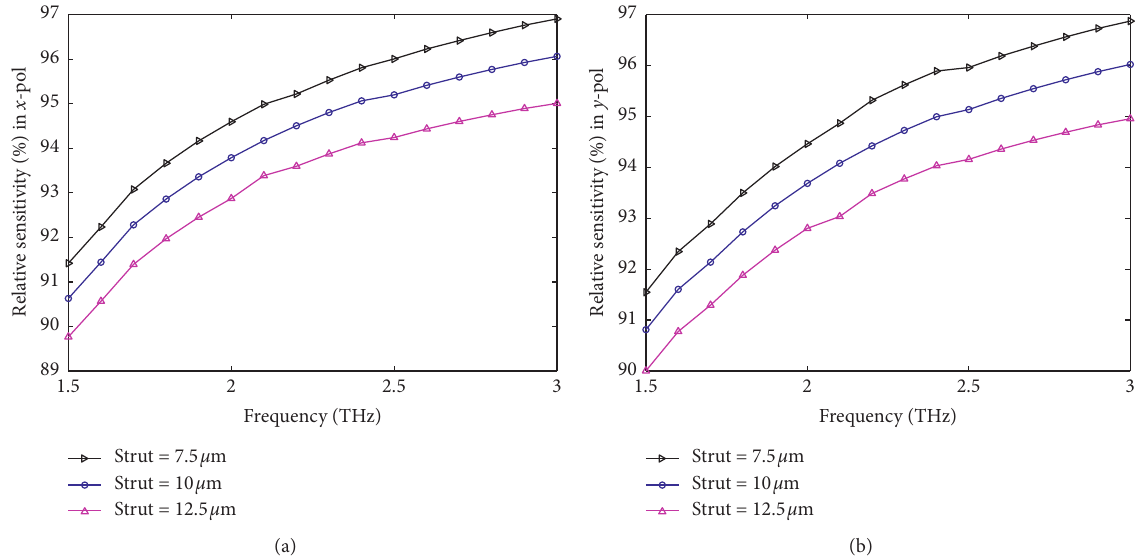
Figure 14: Representation of the relative sensitivity for the three models as a function of the THz band. (a) x -PoM and (b) y